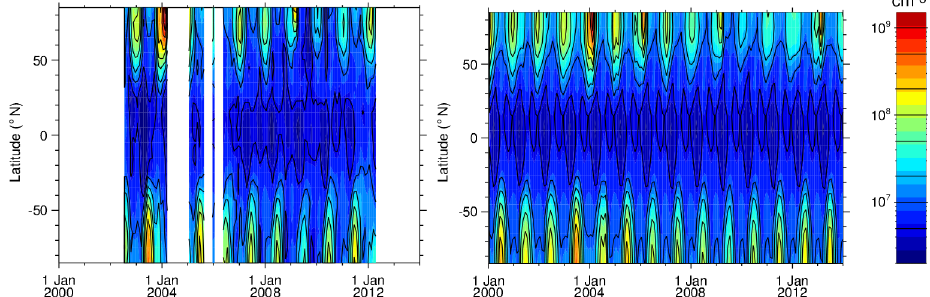
Figure 16. Latitude–time sections of NO y concentrations observed by MIPAS (left) and from the UBC model (right) at